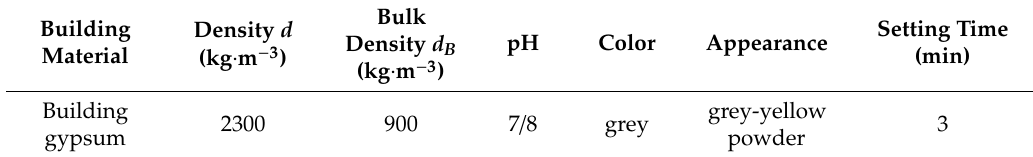
Table 1. Basic physical properties of the building gypsum used in the tests